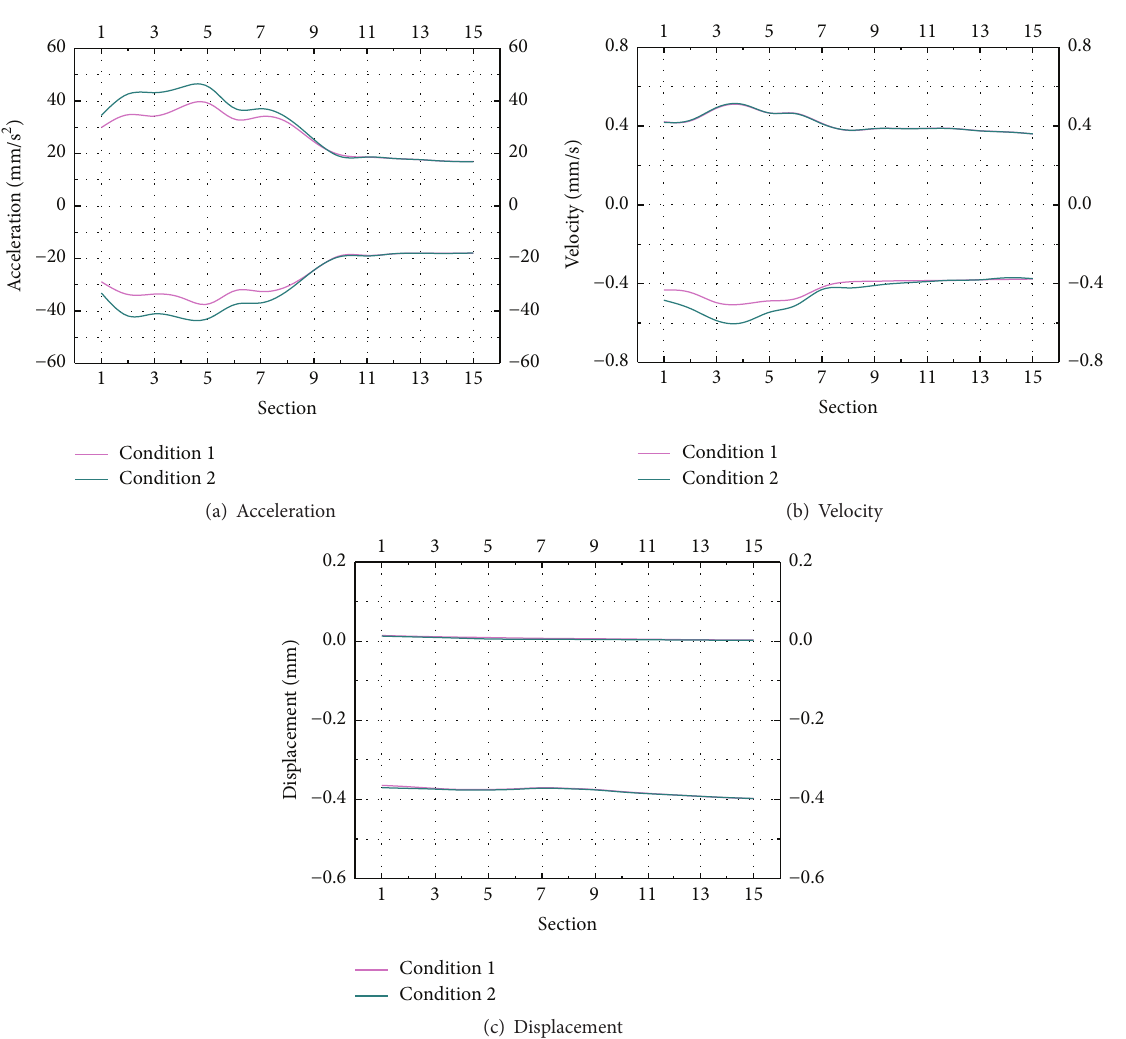
Figure 9: The maximum and minimum values of point B in two conditions: (a) acceleration, (b) velocity, and (c) displacement.